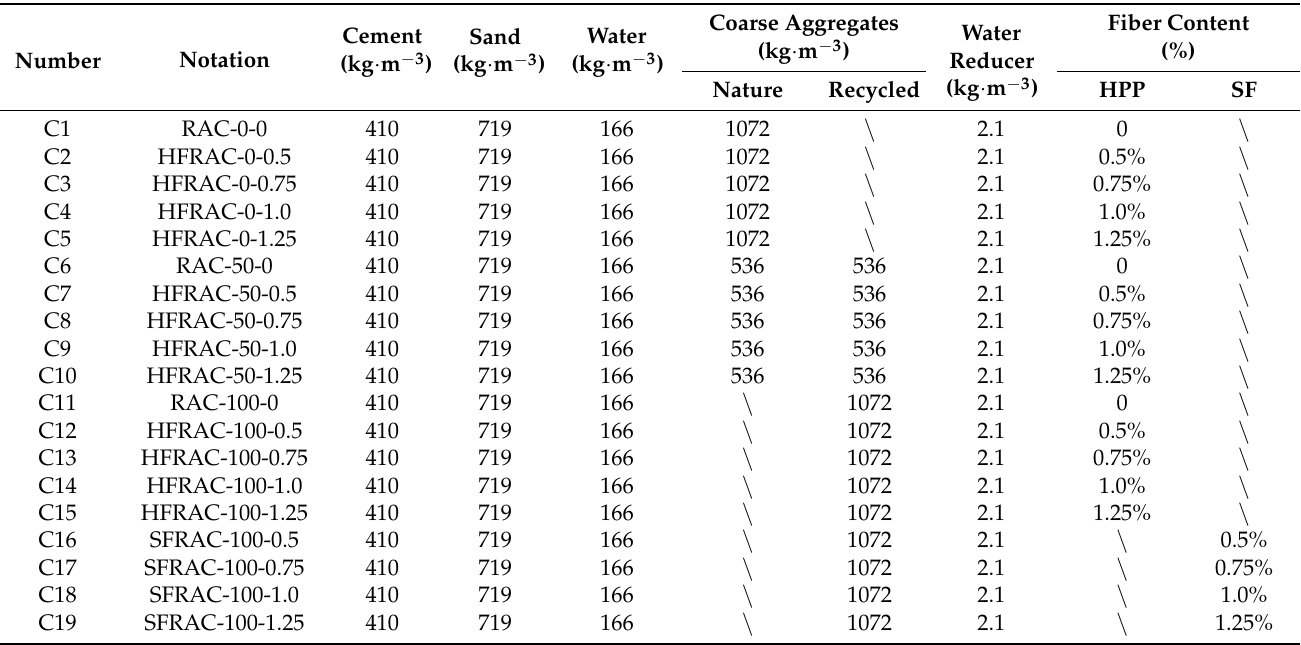
Figure 1. Experimental fibers: ( a ) HPP fiber; ( b ) steel fiber. In order to study the influence of different replacement rates of recycled aggregate, fiber type, and dosage on the impact resistance of RAC, a total of 19 groups of specimens were designed. Four different types of RAC were considered, including three regener- ated aggregate replacement rates (I = 0%, I = 50%, I = 100%), two types of fibers (HPP, SF), and four fiber volume fractions (0.5%, 0.75%, 1.0%, 1.25%). Concrete mix ratios are shown in Table 2. Table 2. RAC proportions of fibers.